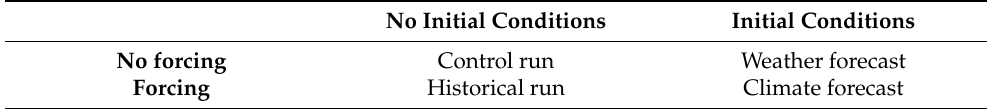
Table 1. Simple model